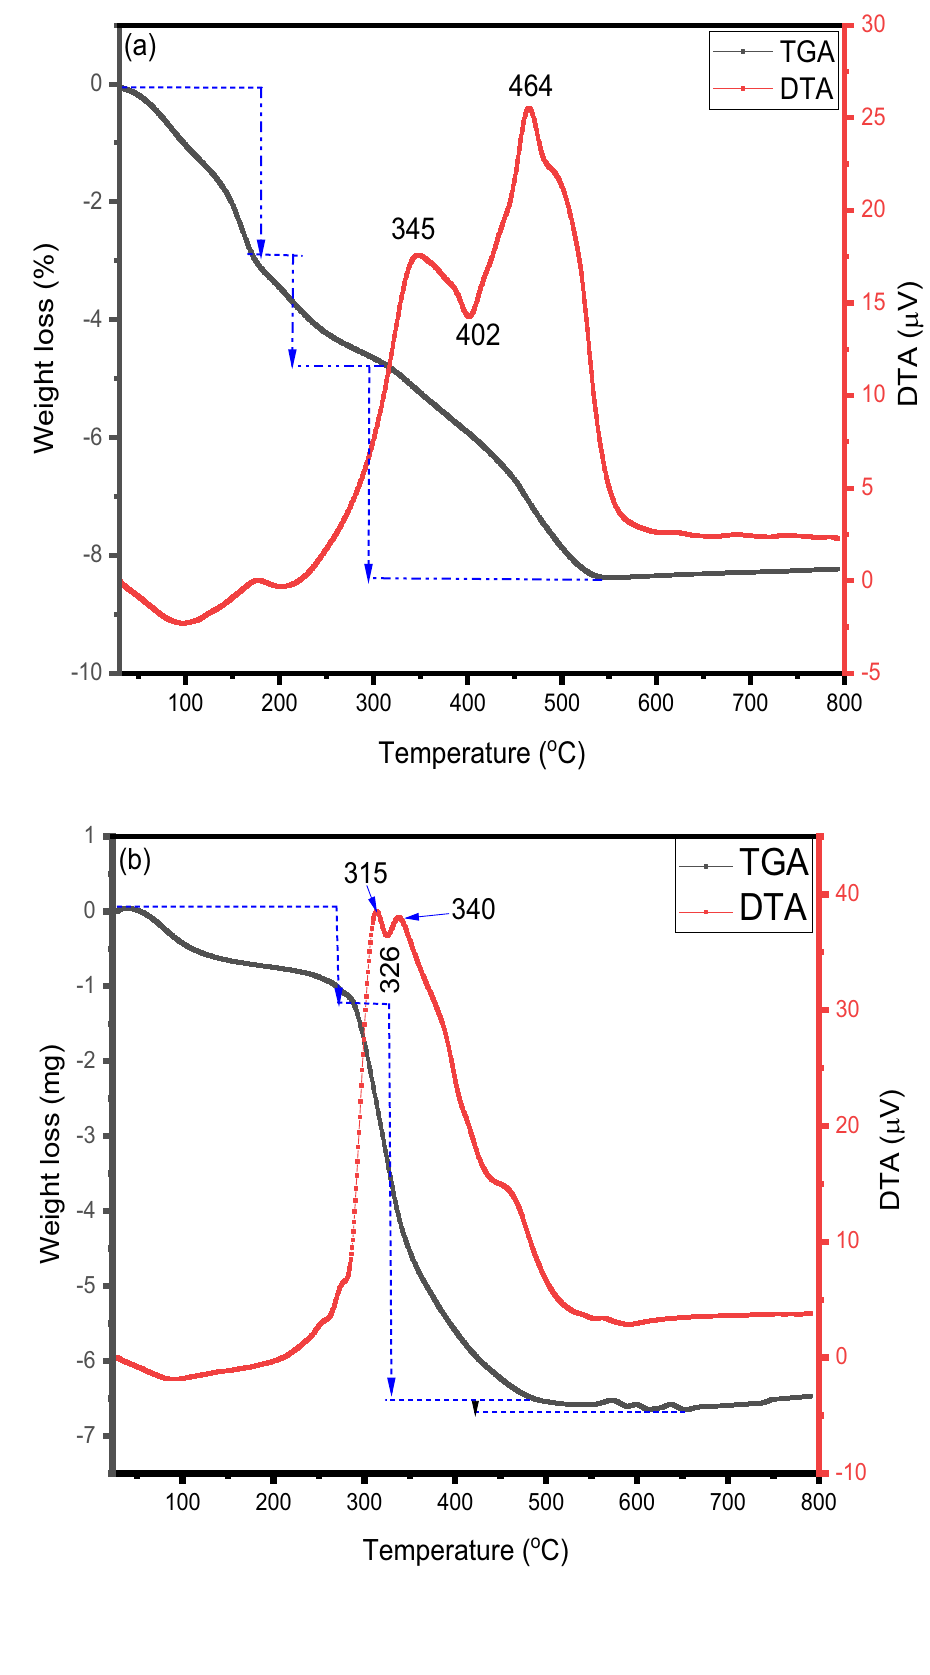
Fig. 4 TGA/DTA illustration of a ZnO nanoparticles, and b Cr–ZnO